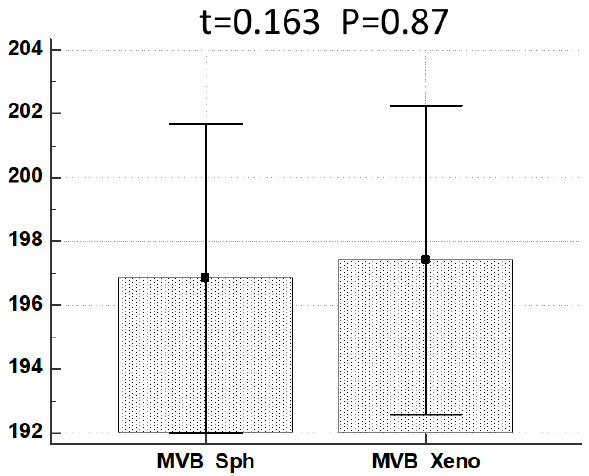
Figure 14. t -test results comparing MVB diameter in MTSs (MVB Sph) and xenografts (MVB